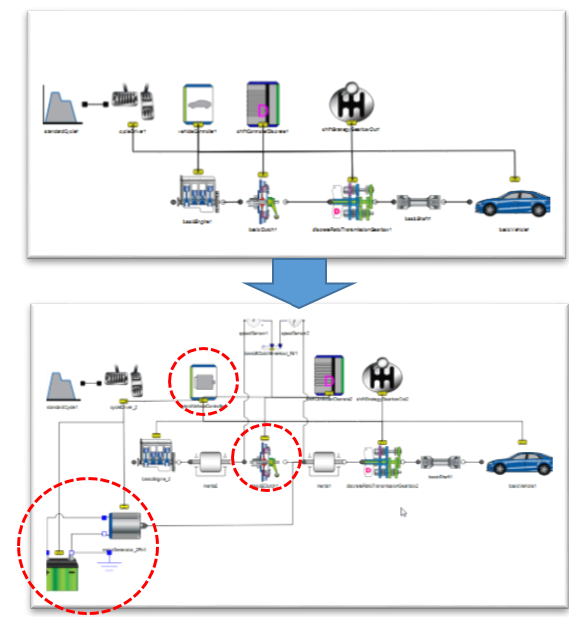
Figure 4. Model hybridization.